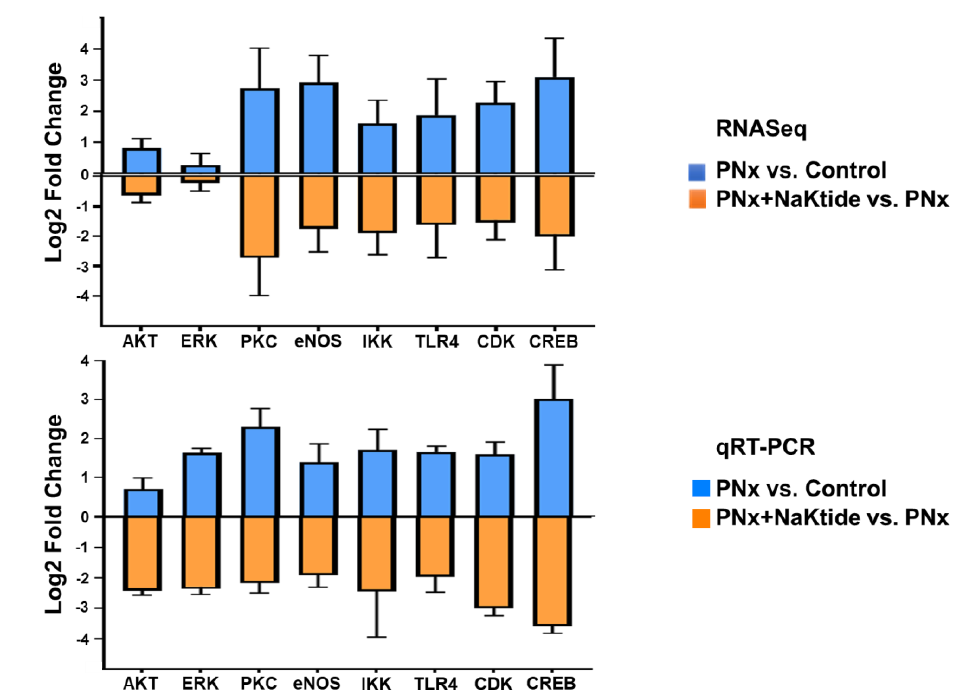
Figure 3. KEGG pathway analysis and validation of RNAseq data in visceral adipose tissue of PNx mice model with alteration of key genes associated with Na,K-ATPase signaling pathway. ( A ) PNx vs. Control ( B ) PNx + NaKtide vs. PNx. NaKtide administration to PNx appears to normalize both up and downregulated gene expression. Blue represents genes upregulated and orange represents genes downregulated. ( C ) Comparative gene expression analysis was done for eight representative genes selected from Na,K-ATPase signaling pathway from transcriptomic data and qRT-PCR. Results are expressed as log 2 values of the fold change.